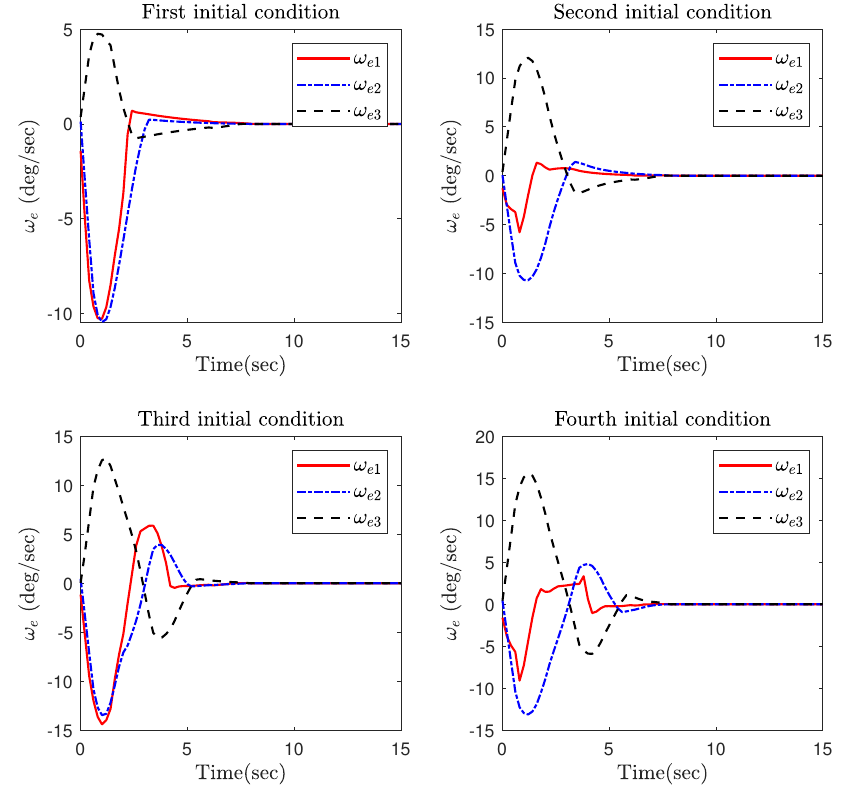
Figure 5. The angular velocity tracking error in Part 1.